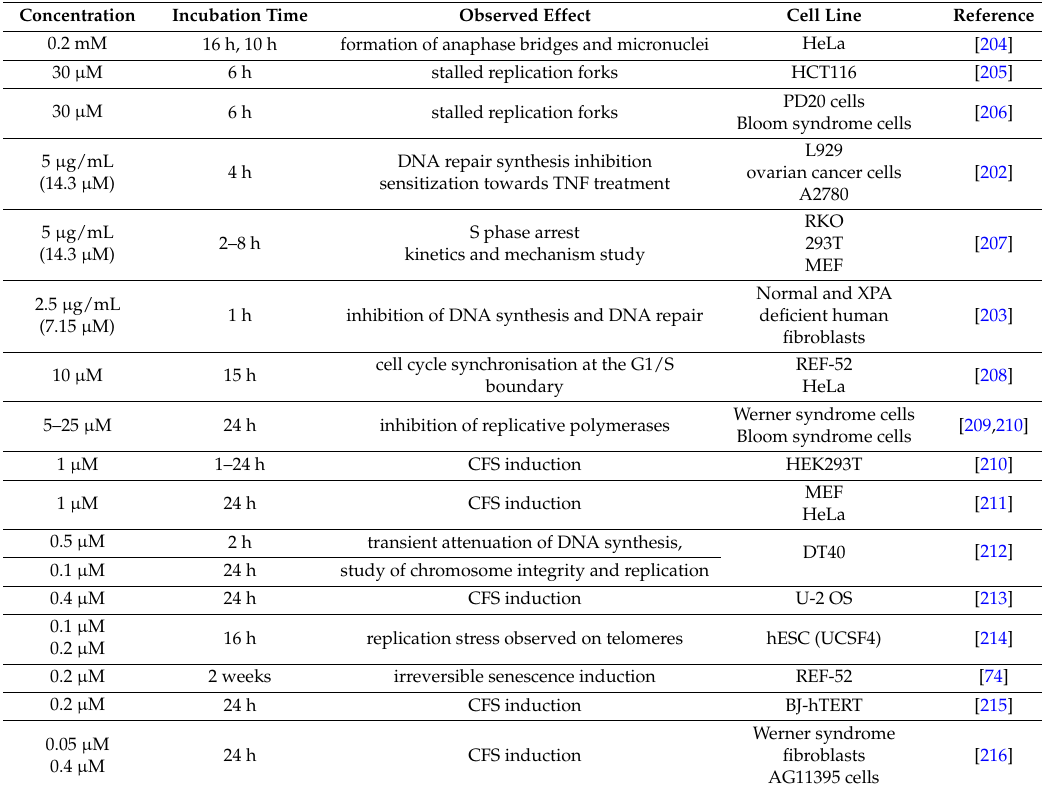
Table 2. Effects of various aphidicolin treatments in